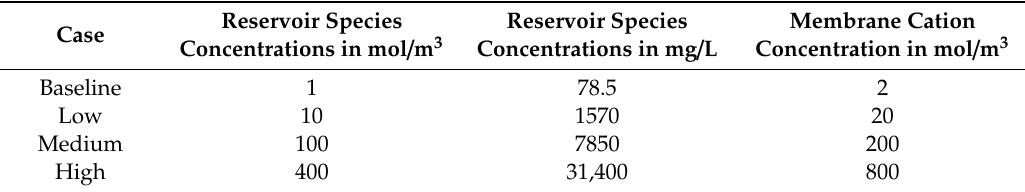
Table 1. Simulated cases.